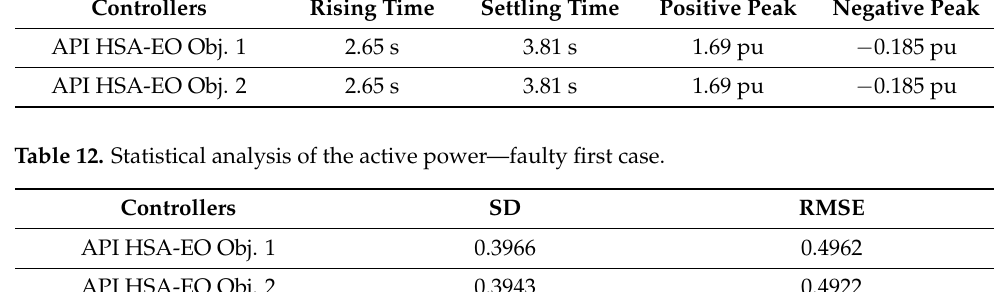
Table 11. Numerical comparison between the controllers at faulty first case. Table 12. Statistical analysis of the active power—faulty first case.